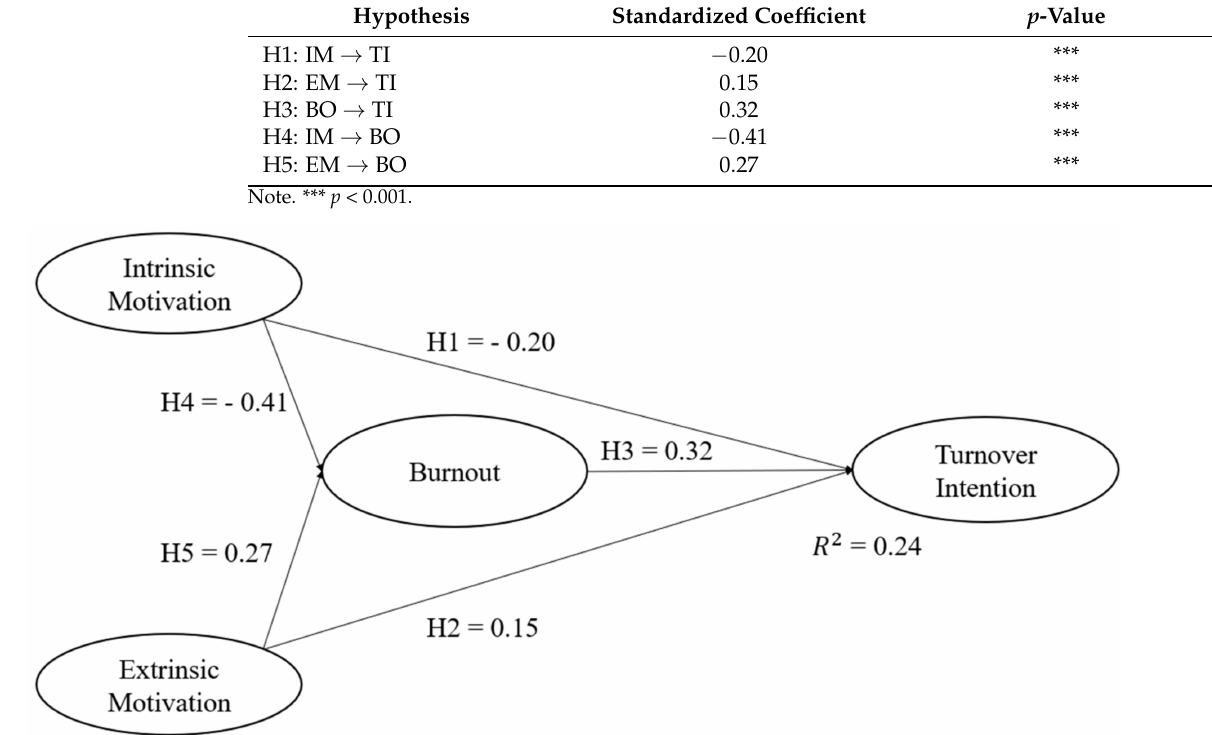
Figure 2. Standardized structural path coefficients. N =